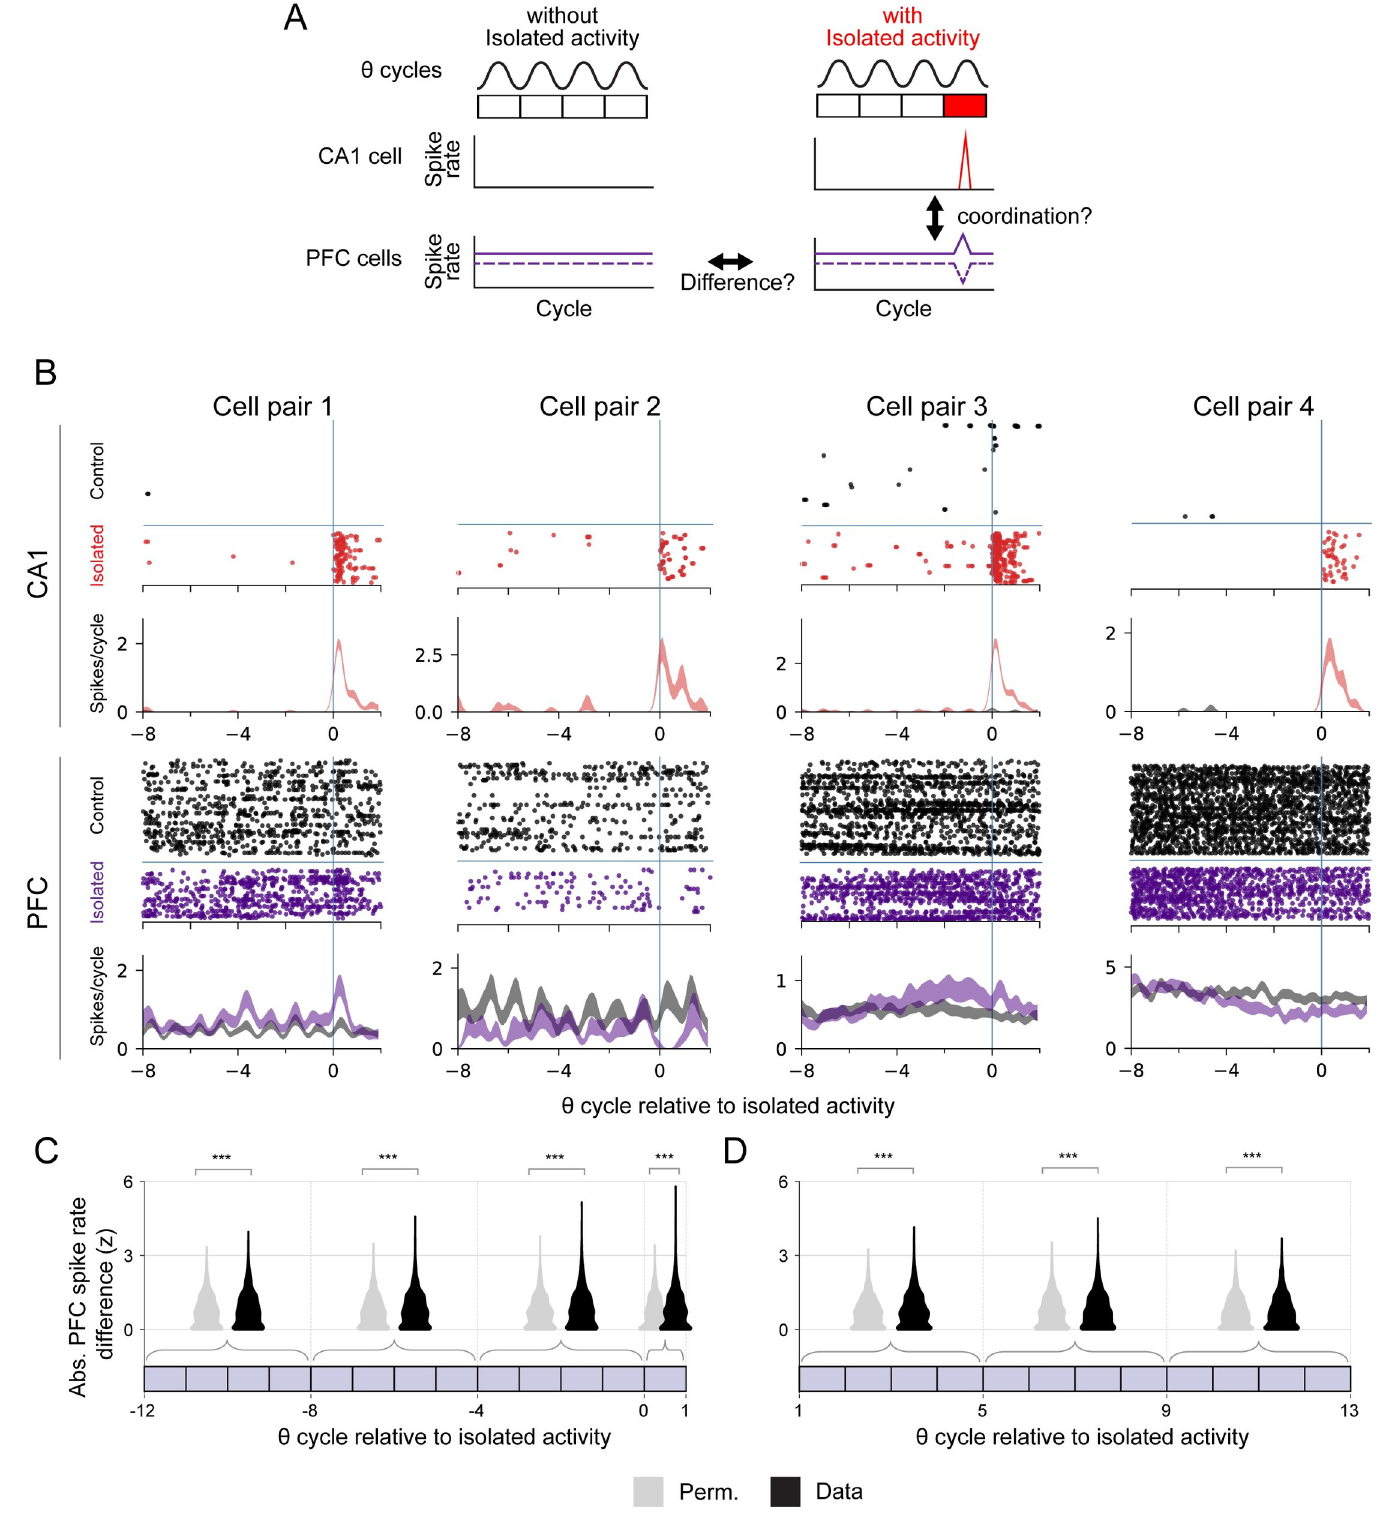
Fig 6. PFC activity is coordinated with hippocampal isolated activity. (A) Schematic illustrating potential CA1 and PFC activity around the time of isolated spiking. Changes in PFC spiking around the time of CA1 isolated spiking may reflect coordination between the 2 regions. (B) Example spike raster and spiking rate (mean ± SEM)